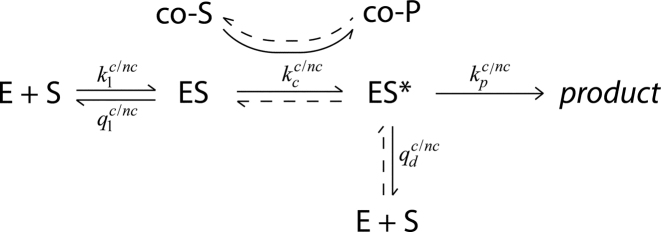
A general scheme of kinetic proofreading. A substrate S is turned into product by an enzyme E. The substrate associates to the enzyme with an association rate constant k1, after which the complex could either dissociate with a dissociation rate constant q1 or form a high energy intermediate complex ES*. The formation of ES* is facilitated by the enzymatically coupled processing of the co-substrate co-S to form a co-substrate co-P. The high energy intermediate ES* may either dissociate with a rate constant qd or continue to product formation with a rate constant kp. The formation of the intermediate ES* is energetically driven by the shift in concentration of co-S far above equilibrium with co-P.